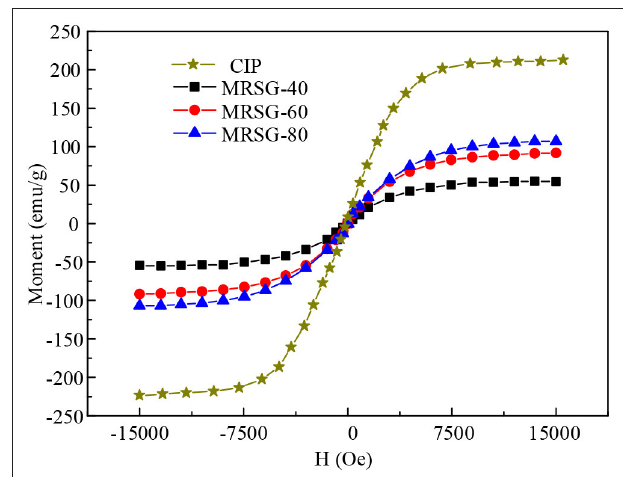
FIGURE 1 | Magnetization curve of MR gels and CIP at room